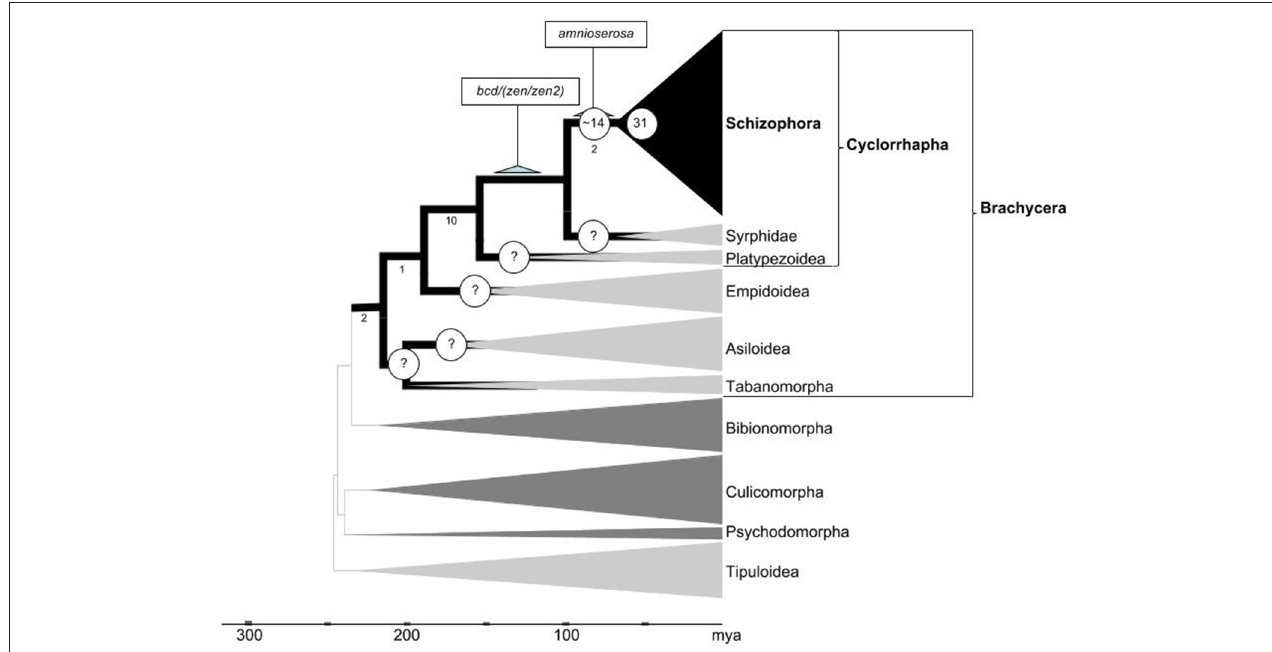
FIGURE 6 | Inferred developmental gene duplicate accumulation in relation to the dipteran tree life. Phylogenetic framework adapted from Wiegmann et al. (2011) and Caravas and Friedrich (2013). Clades in which gene family evolution could be studied using genomic sequence data sets are indicated by dark gray or black shade. Numbers below select branches indicate sum of branch-specific shared derived character states based on ( Lambkin et al., 2013). Terminal clade widths represent relative species numbers with Schizophora counting over 50,000 described species. Nodes with question marks highlight high priority groups to be sampled in future work. Numbers of Drosophila lineage-specific expanded gene families during early cyclorrhaphan and schizorrhaphan diversification given at respective node branches. Scale at bottom indicates evolutionary time span in millions of years ago